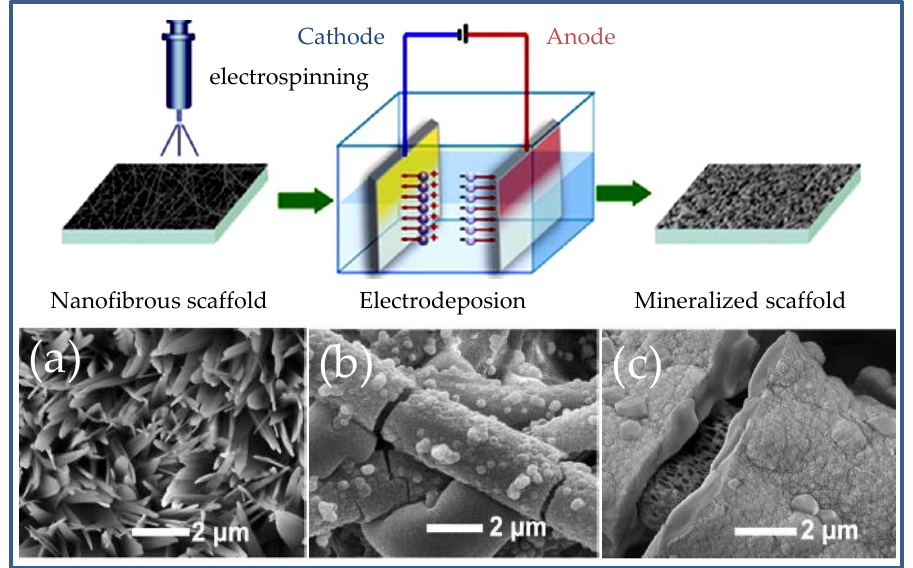
Figure 4. Scheme showing the fabrication of mineralized nanofibers by means of a final electrodeposition step (top). SEM micrographs of mineralized PLLA matrices are shown in the bottom: ( a ) electrodeposition at 3 V, 60 °C for 60 min; ( b ) mineralization in SBF for 12 days; and ( c ) mineralization in SBF for 30 days. Reproduced with permission from [68], Elsevier, 2013.